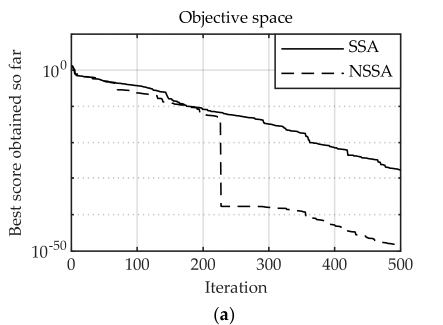
Figure 7. Convergence comparison between SSA and RSSA: ( a ) 𝑓 (cid:2869) ; ( b ) 𝑓 (cid:2876) ; ( c ) 𝑓 (cid:2869)(cid:2872) ; ( d ) 𝑓 (cid:2869)(cid:2873) .